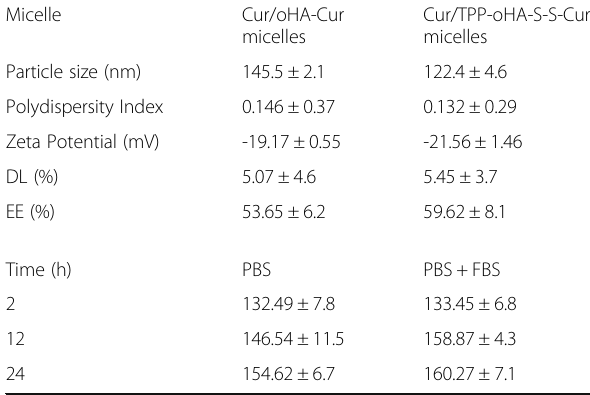
Table 1 The physicochemical properties and stability of Cur/TPP-oHA-S-S-Cur micelles in PBS and PBS within FBS ( n =